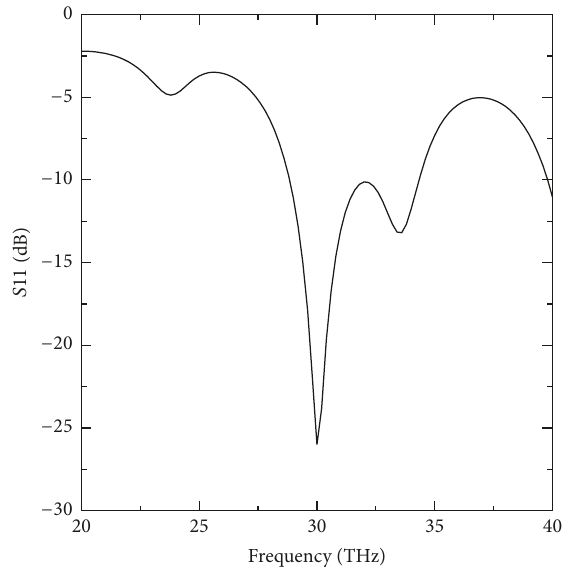
Figure 3: Simulated return loss for a single antenna.